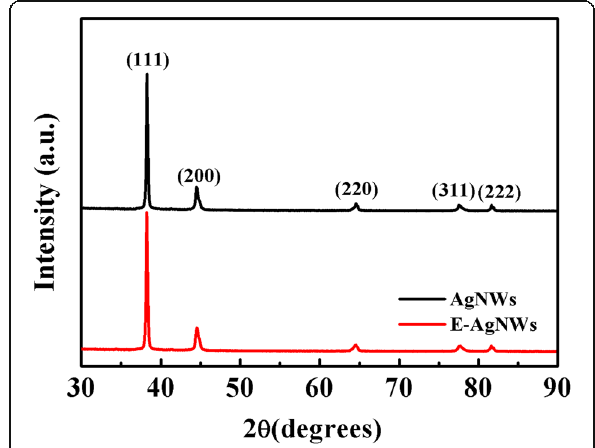
Fig. 5 XRD pattern of the as-synthesized and chemically etched Ag nanowires